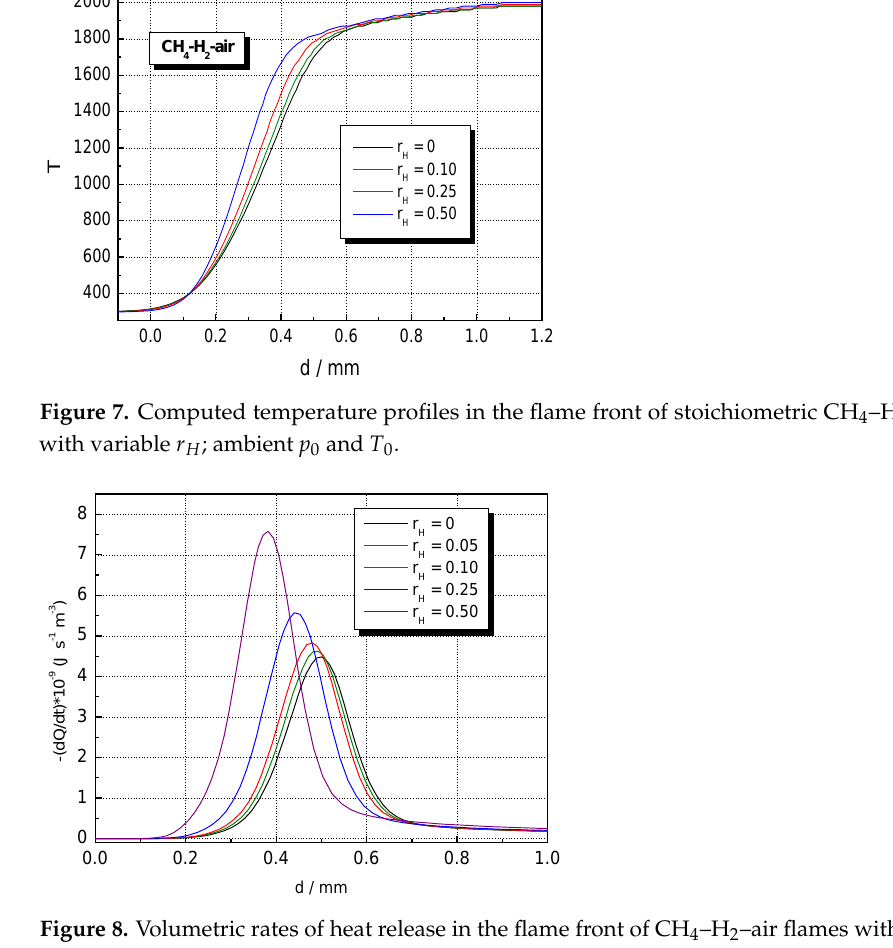
Figure 8. Volumetric rates of heat release in the flame front of CH 4 –H 2 –air flames with variable r H ; ambient p 0 and T 0 .